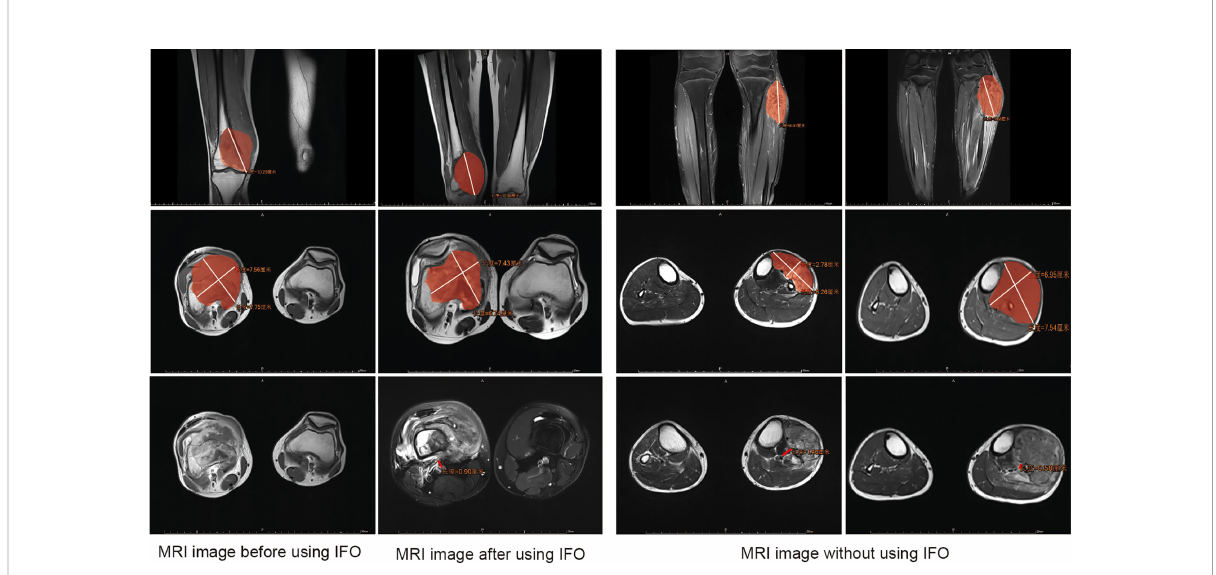
FIGURE 2 Assessment of the tumor mass volume (TMV) and the shortest distance from the center of main blood vessels to the margin of the tumor lesion (NBT) in MRI. Area covered in red represents the tumor